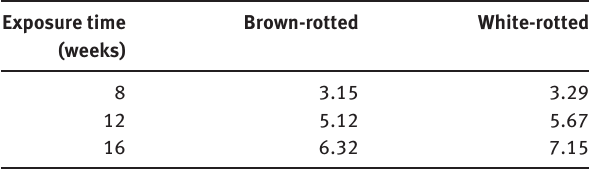
Table 2 Effect of fungal decay on the weight loss (%) of BF/PP composites at different exposure times.